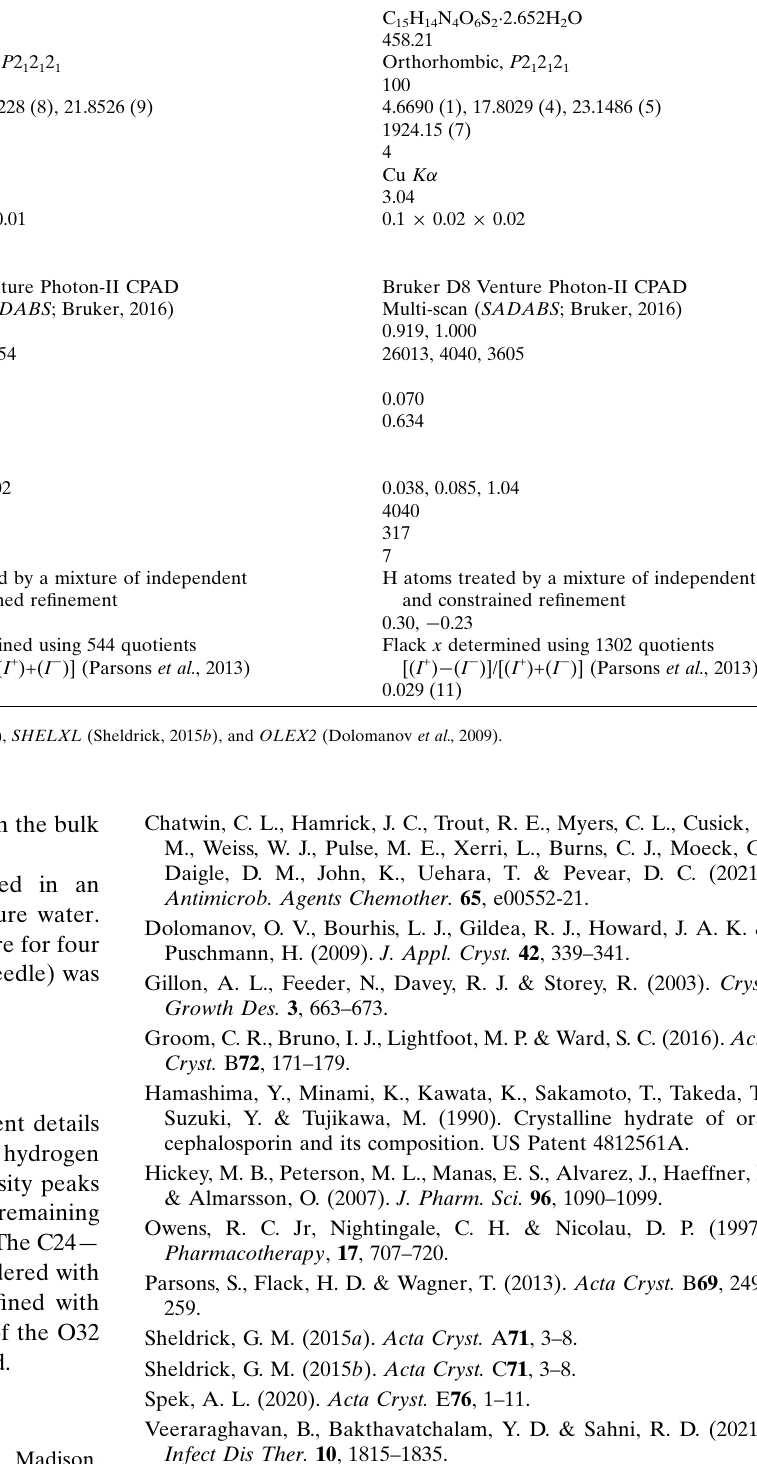
Table 3 Experimental details. Crystal data Chemical